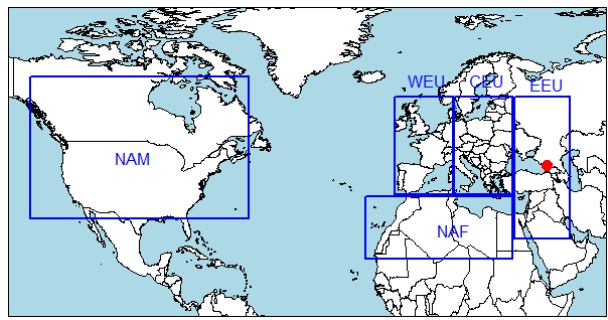
Figure 2. The five sub-regions classified as potential rBC emission source regions. The Elbrus drilling site is indicated by a red circle. WEU, CEU, EEU, NAF and NAM represent western Europe, cen- tral Europe, eastern Europe, northern Africa and North America,